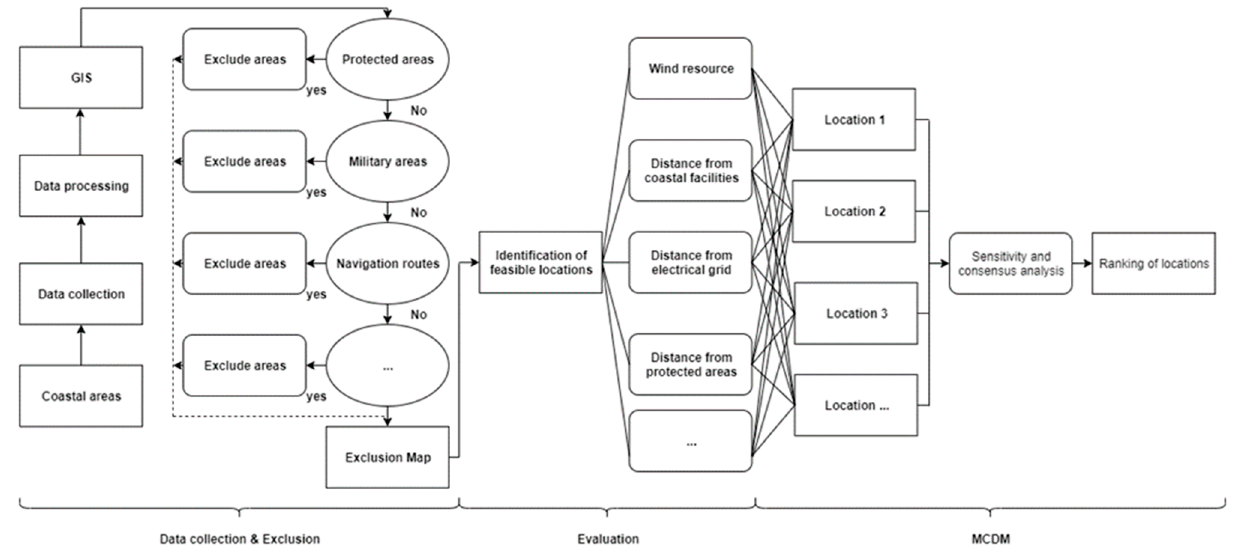
Figure 2. Flowchart of the methodological framework used in this paper.